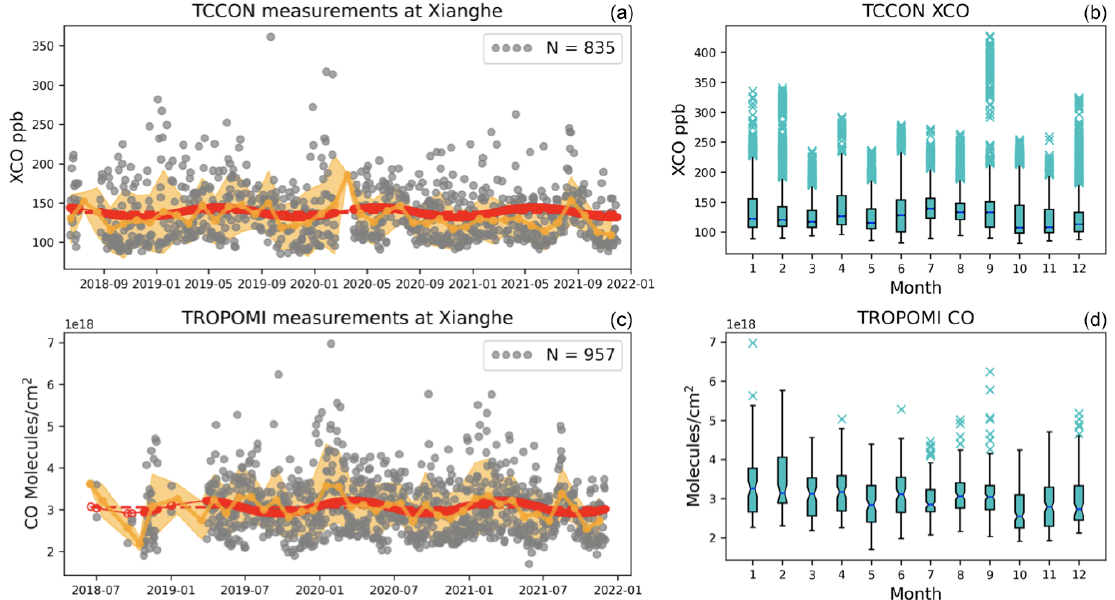
Figure A1. (a, c) Time series of XCO and CO columns observed by TCCON at Xianghe (a) and TROPOMI overpass within 50km around Xianghe (c) between June 2018 and November 2021. Gray dots are daily means with the total number indicated by N, the dotted orange line is the monthly mean, the shaded yellow area is the monthly standard deviation, the dashed red line is the offset A 0 (almost overlapping with the solid red line), and the solid red line is the fitted time series y(t) . (b, d) The monthly box plot of the CO columns in each month. The bottom and upper boundaries of the box represent the 25% (Q1) and 75% (Q3) percentile of the data points around the median value, the error bars extend no more than 1.5 × IQR (IQR = Q3 − Q1) from the edges of the box, and the blue crosses are the extremely low and high